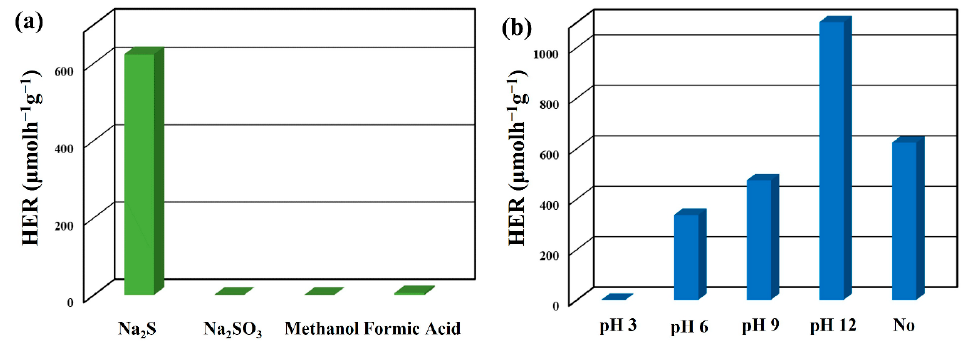
Figure 7. The average HER of optimized Cu 2 O/CuS/ZnS nanocomposite at ( a ) sacrificial reagents and ( b ) different pH values.